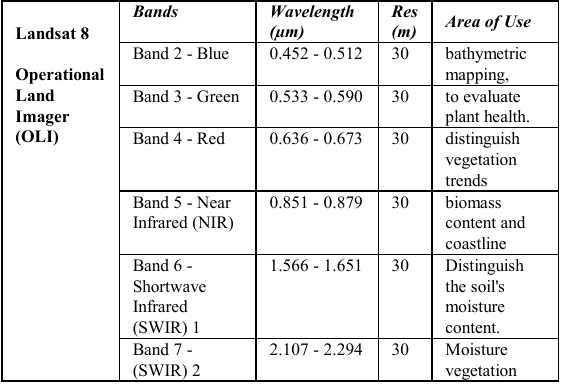
Table 1. Landsat 8 Operational Land Imager (OLI) Sensor